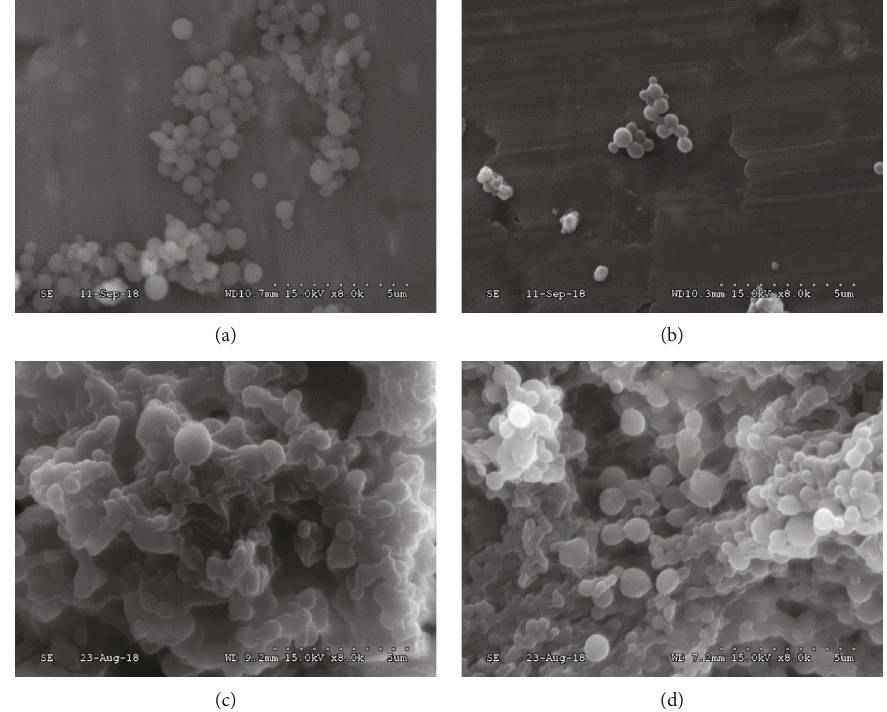
Figure 5: SEM images of Ropi-loaded 1-PCL spheres (a), Ropi-loaded 4-PCL spheres (b), 1-PCL spheres after release assay for 58 h (c), and 4-PCL spheres after release assay for 58 h (d). The scalebar = 5 μ m .